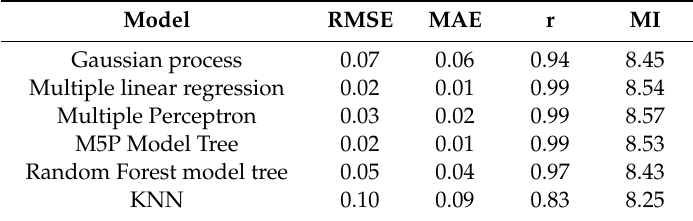
Table 3. Summary of performance for multiple ML models.